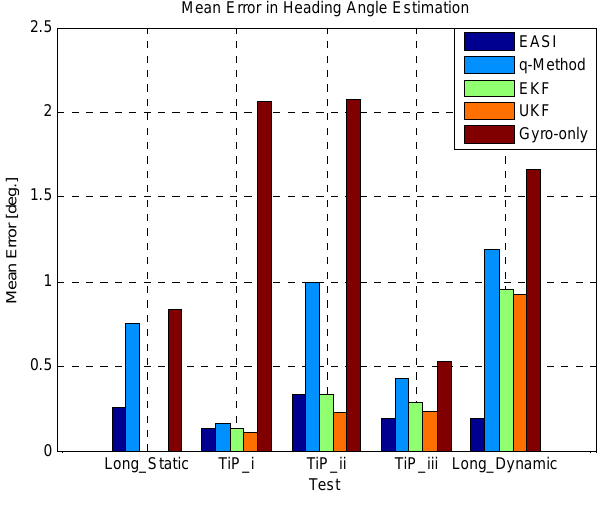
Figure 24. Mean error in all five tests.